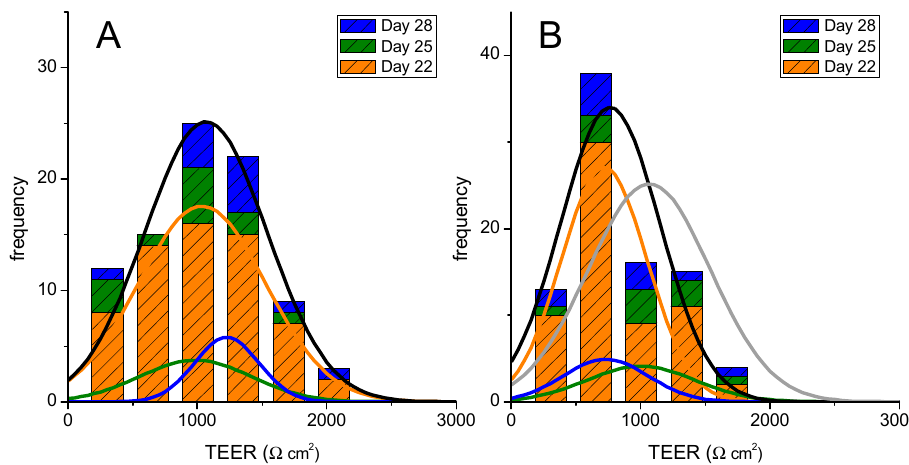
Figure 1. Evaluation of the Caco-2 monolayer integrity when used for a single permeability assay at distinct days after seeding (22, 25, and 28). The TEER values obtained before are shown in Plot ( A ), and after the permeability assay in Plot ( B ). The lines are the best fit of a Normal distribution to the results obtained on each day (colored lines) or cumulatively at all days (black line). The grey line in Plot B is the overall distribution obtained before the permeability experiment.